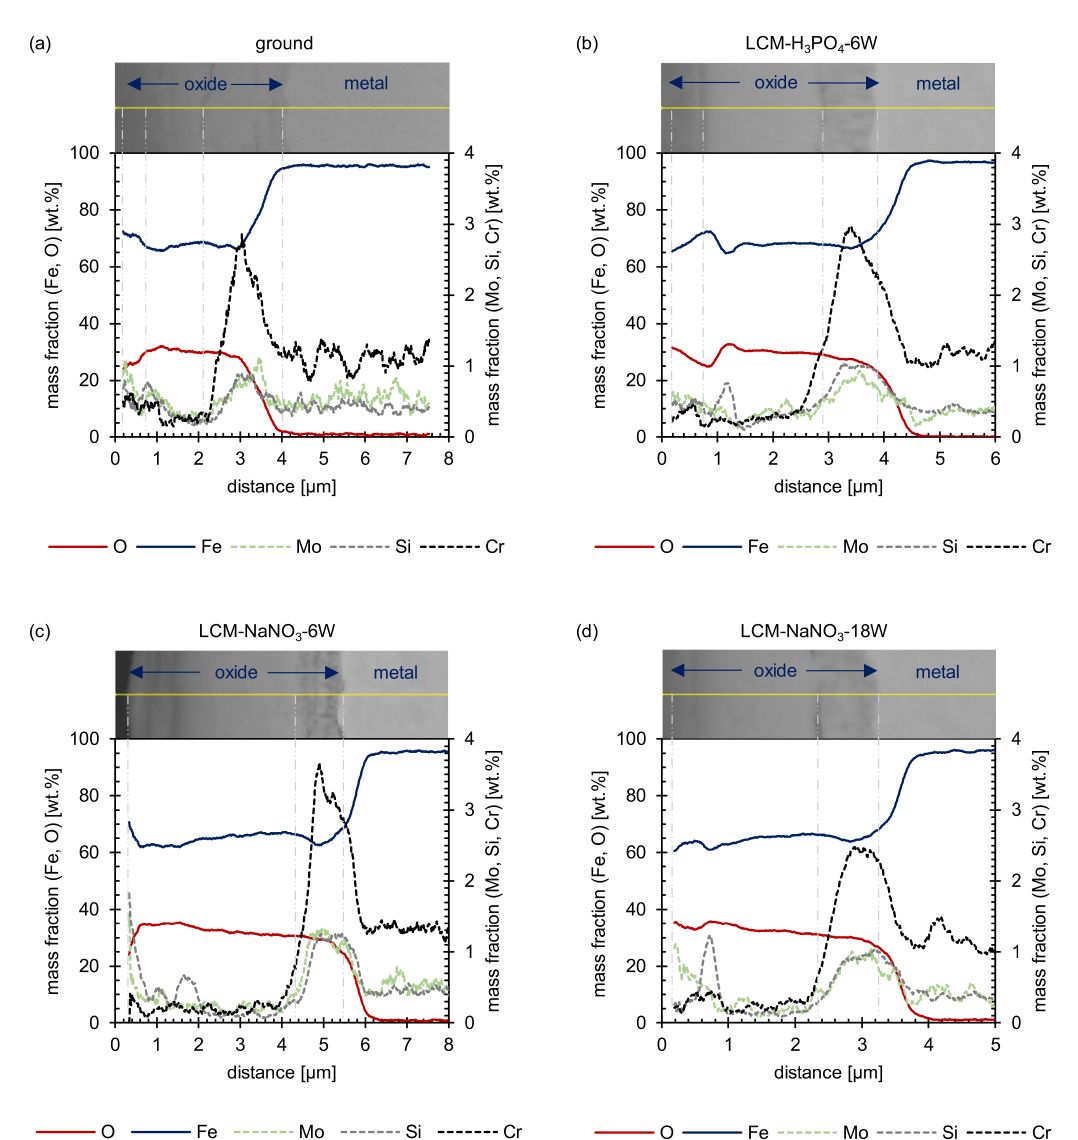
Figure 11. EDS line scans after oxidation of ( a ) ground, ( b ) LCM-H 3 PO 4 -6W, ( c ) LCM-NaNO 3 -6W and ( d ) LCM-NaNO 3 -18W 42CrMo4 steel at 500 ◦ C for 20 h.